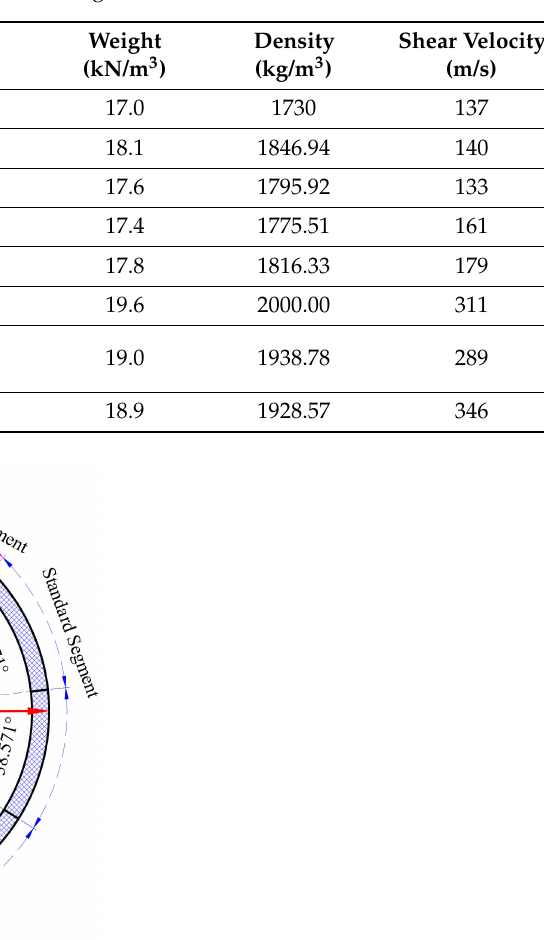
Table 1. The stratigraphic parameters of Shanghai site.